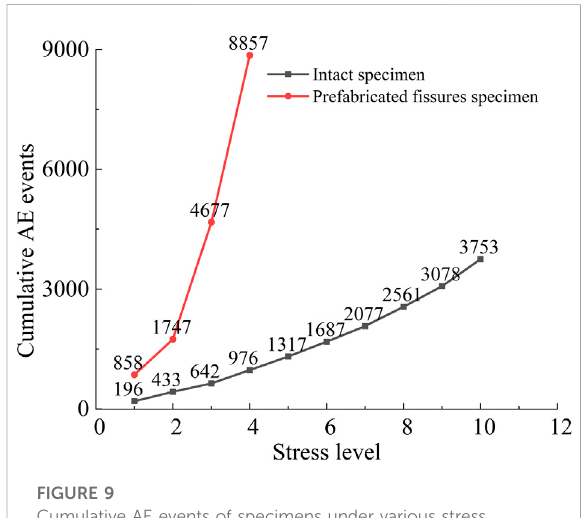
FIGURE 9 Cumulative AE events of specimens under various stress